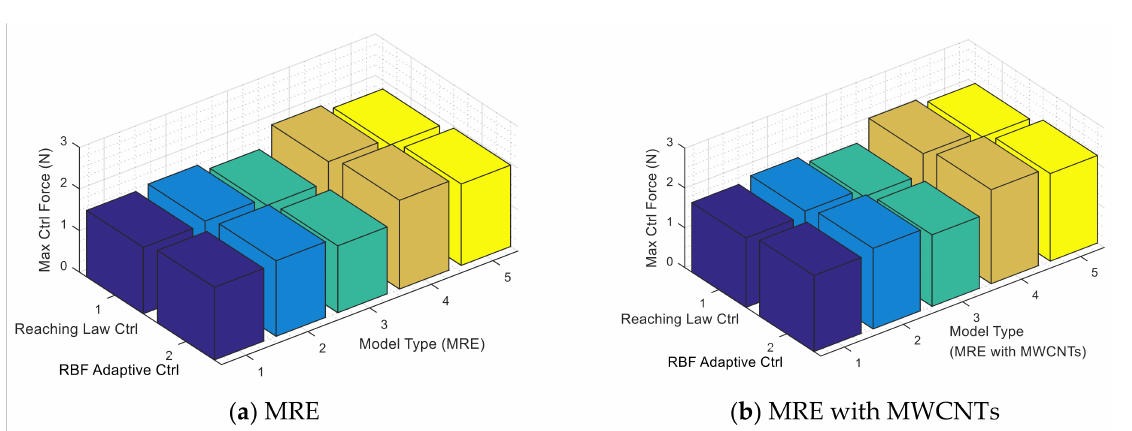
Figure 22. Max Control Force for Different Control